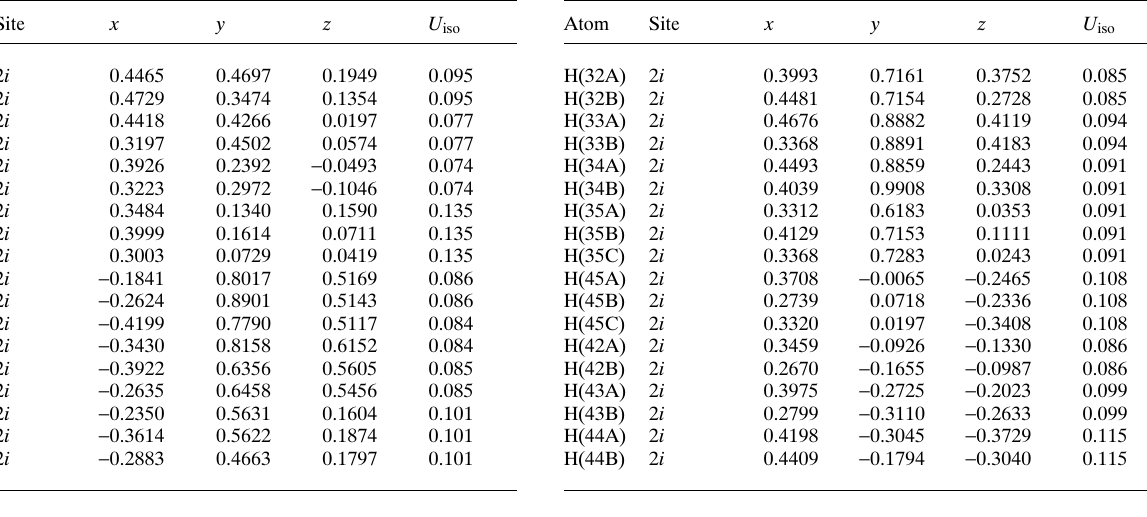
Table 2. Atomic coordinates and displacement parameters (in Å 2 )